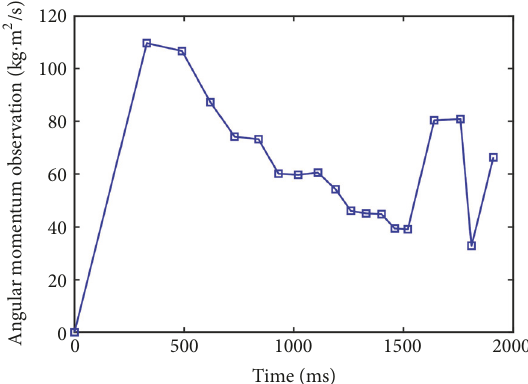
Figure 6: Load momentum observation during AMT startup under the first gear.